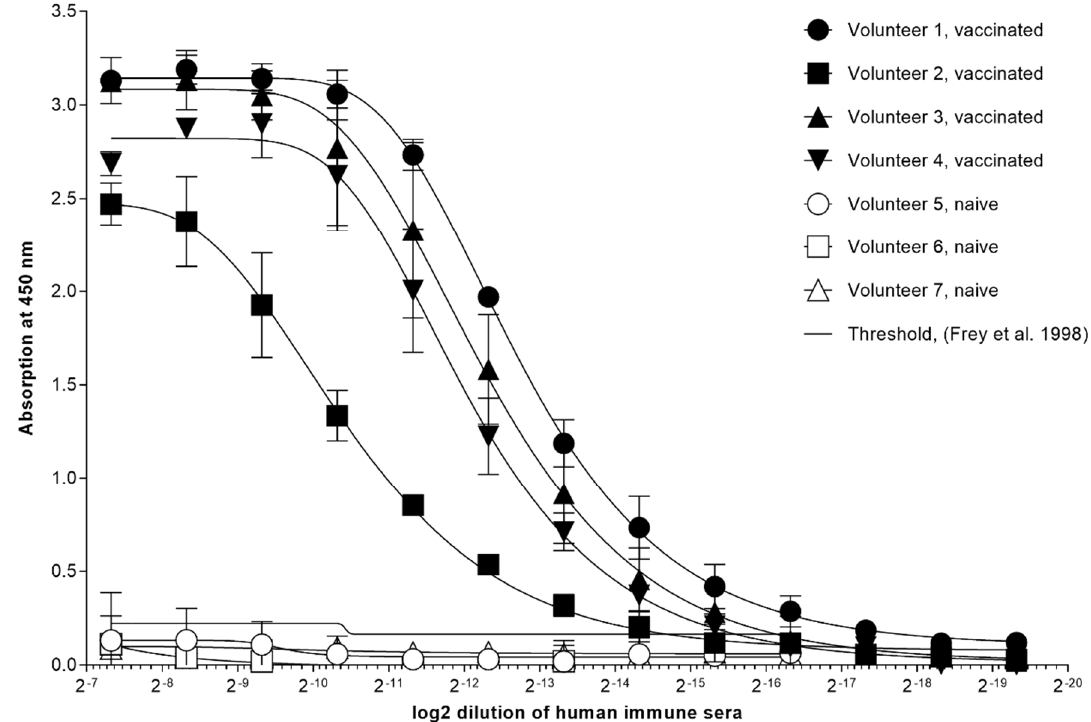
Figure 1. Circulating anti-VACV IgG in sera of four volunteers was measured by indirect ELISA. Blood samples were either taken 20 days (Volunteer 1 and 2) or 28 days (Volunteer 3 and 4) after immunization with Dryvax ® (Wyeth Laboratories, Inc., Marietta, GA, USA). Three volunteers (Volunteer 5 to 7) were not vaccinated. Sera were titrated in twofold serial dilutions.